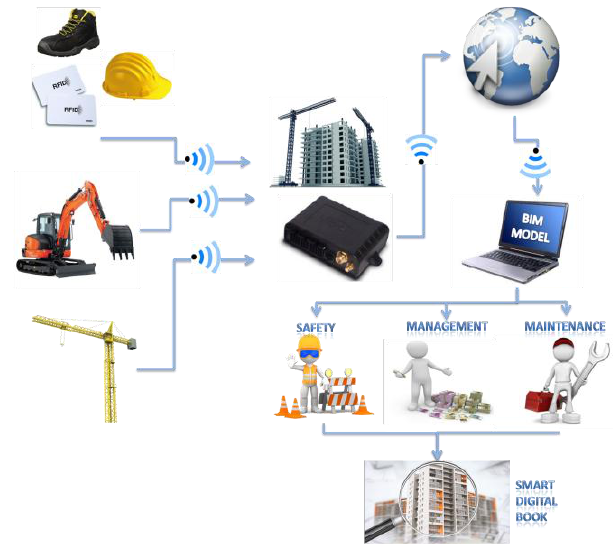
Figure 1: scheme of system